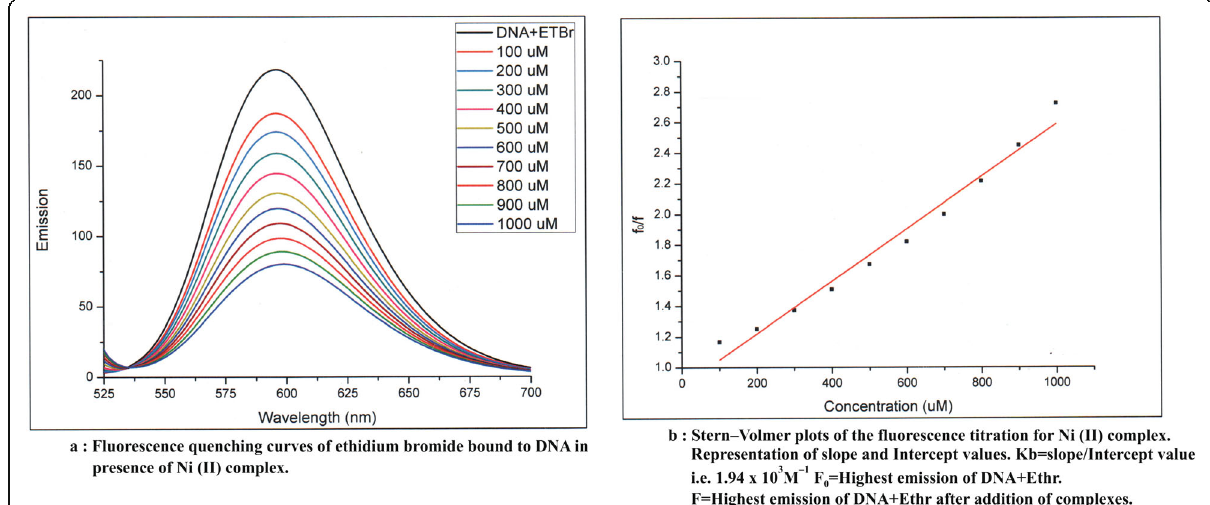
Fig. 7 a Fluorescence quenching curves of ethidium bromide bound to DNA in presence of Ni (II) complex. b Stern-Volmer plots of the fluorescence titration for Ni (II) complex. Representation of slope and Intercept values. Kb = slope/Intercept value i.e. 1.94 × 10 2 M -1 F0 = Highest emission of DNA+Etbr, F = Highest emission of DNA+Etbr after addition of complexes